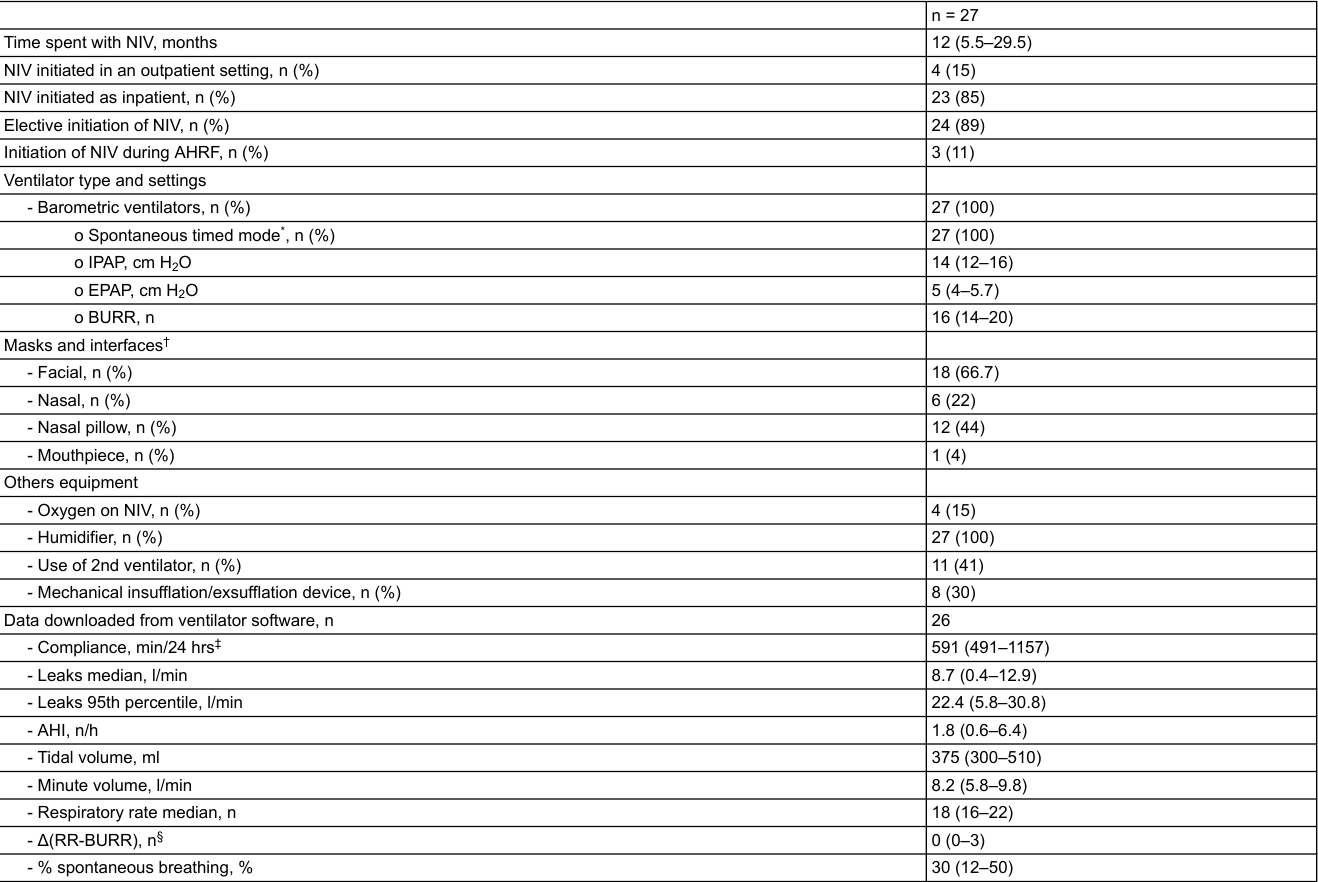
Table S1: Ventilator settings, masks and data downloaded from the